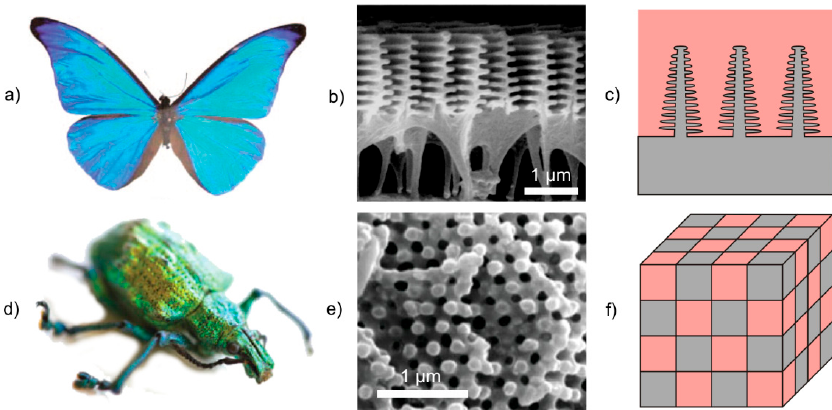
Figure 11. Examples of structural colors in nature: ( a – c ) Morpho butterfly and ( d – f )